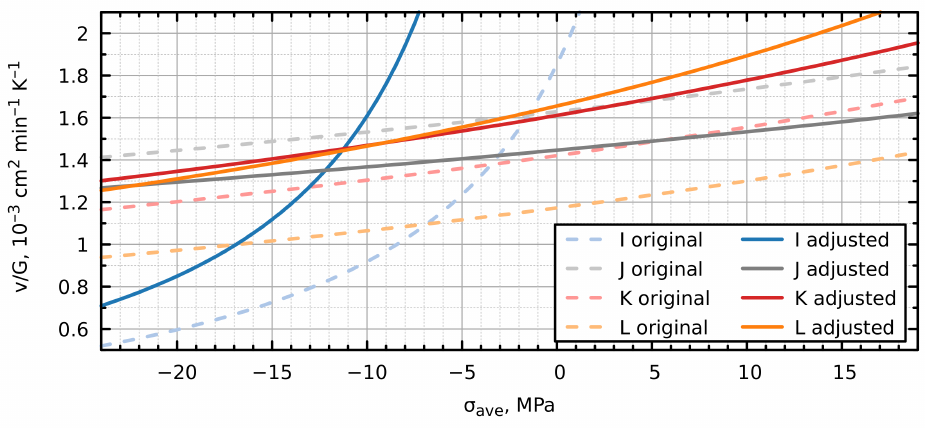
Figure 6. The influence of thermal stress on ξ crit for original and adjusted PD parameter